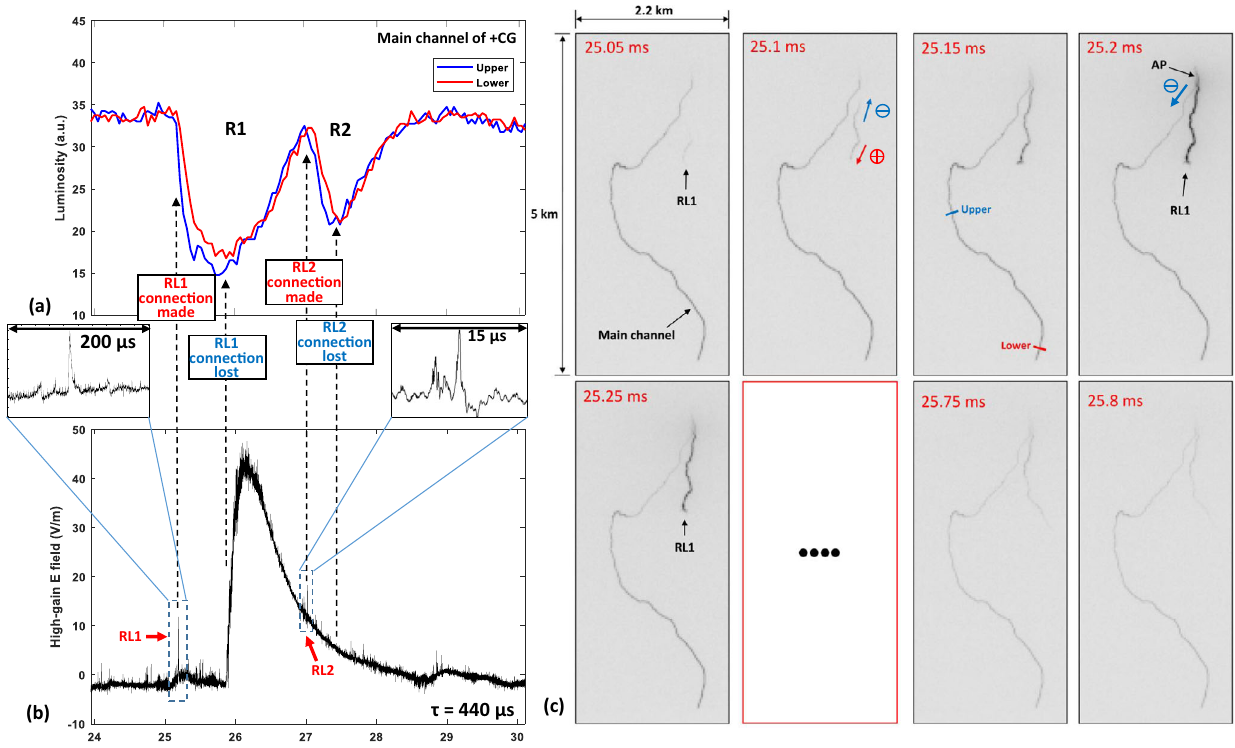
Fig. 4 Single-stroke positive Flash 1906. a , b “ Region 2 ” of Fig. 3a, c shown on an expanded time scale. Microsecond-scale E- fi eld pulses associated with collisions of recoil leaders RL1 and RL2 with the main channel are marked in b and shown expanded in two panels between a , b . R1 and R2 in a are luminosity dips with their onset times corresponding to the microsecond-scale pulses marked in b . c Selected individual frames showing the evolution of RL1. Bidirectional extension of RL1 is seen in Frames 25.05 ms to 25.15 ms. Connection to the main channel is established in Frame 25.2 ms (AP stands for attachment point), and in Frame 25.8 ms this connection is almost completely decayed (essentially lost). Luminosity of the main channel decreased as a result of connection of RL1 to the main channel and started increasing (recovering) when the connection